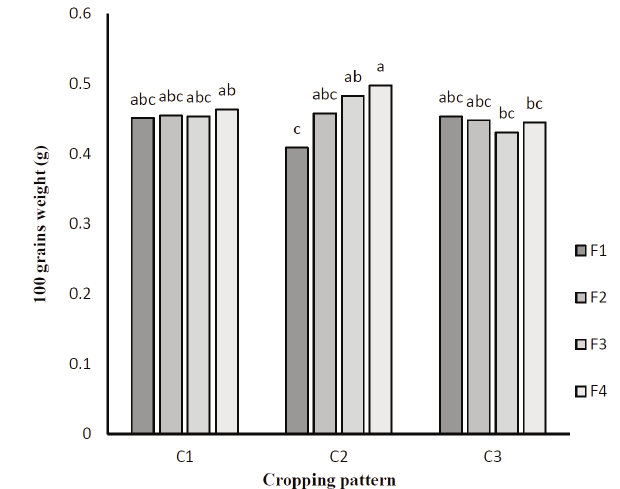
Fig. 1 ­ Mean 100 grain weight of black mustard for interaction of cropping pattern × fertilizers. Different letters indicate significant difference at p ≤ 0.05 (Duncan test). C1, C2, C3= pure stands of bean and black mustard,additive intercropping with a ratio of 50% black mustard + opti­ mum density of pinto bean mono cultures and additive intercropping with optimum density of two species in mono cultures, respectively. F1, F2, F3, F4= control (non­ fertilizer), bio­fertilizers (azotobarvar 1 and barvar 2), bio­fertilizer + 50% chemical fertilizer urea and bio­fertili­ zers + 100% chemical fertilizer (urea),